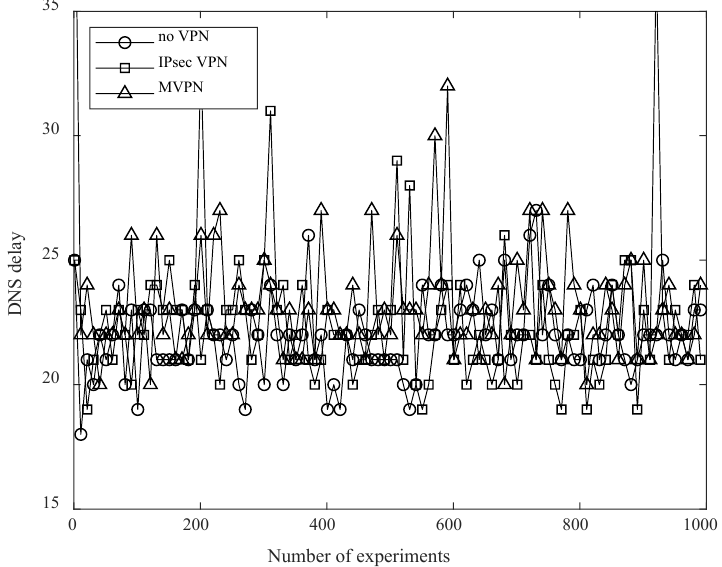
Figure 13. DNS delay test results.